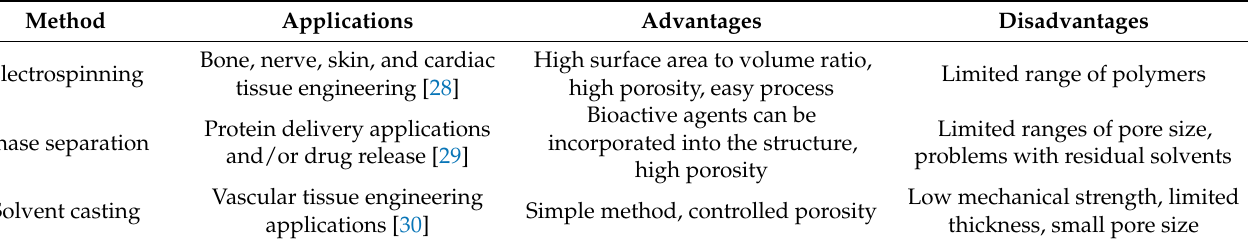
Table 1. Selected scaffolds’ formation techniques—main applications and advantages/disadvantages.